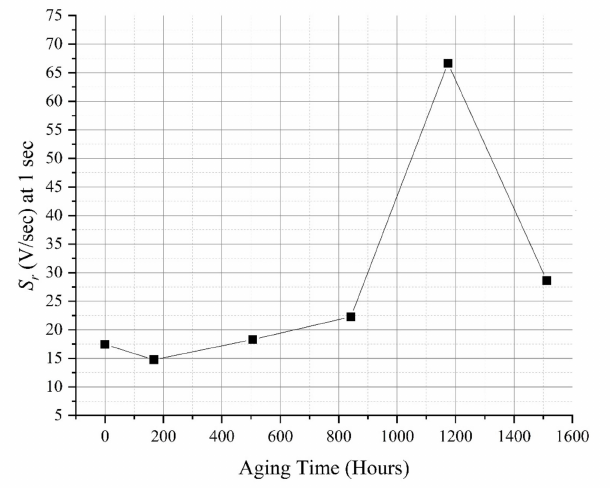
Figure 10. S r at 1 second variation against different thermal aging periods for EPR insulation.